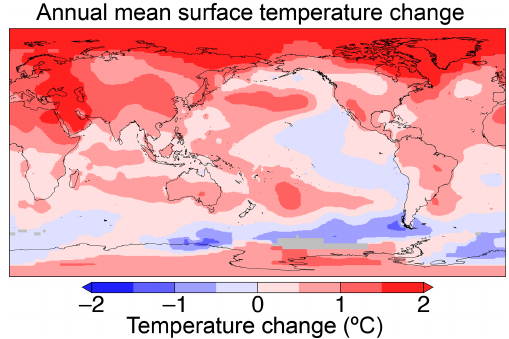
Figure 10. Observed 35-year (1981–2015) annual mean surface temperature changes from the NASA GISS surface temperature